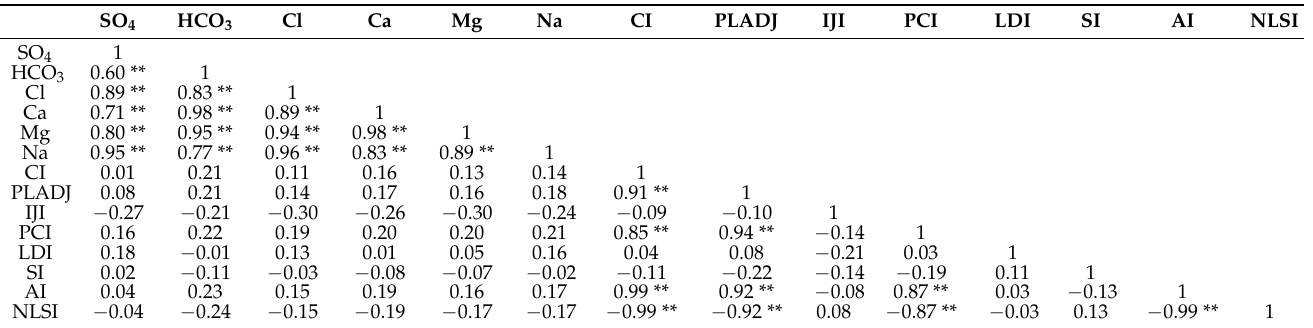
Table 4. Results of the Pearson correlation test between CEC variables and landscape configura- tion